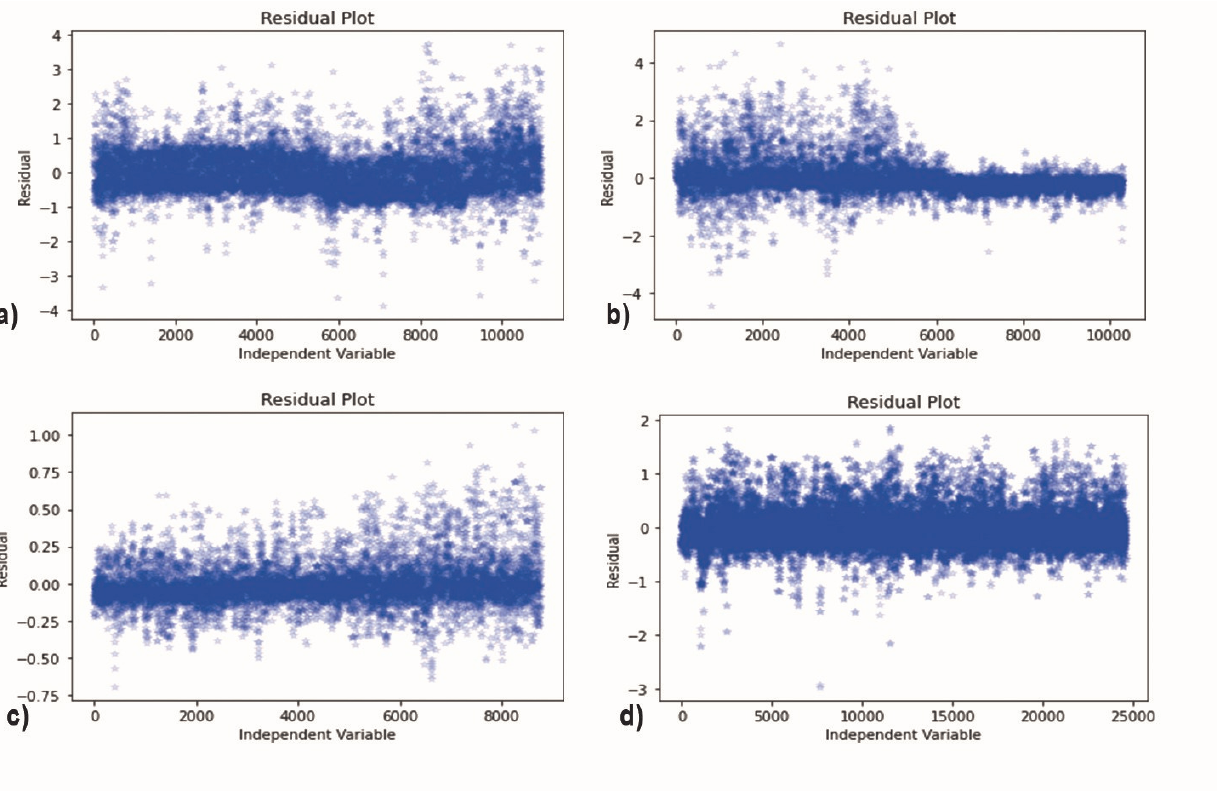
Figure 3. ( a ) Plot of the residuals resulting from the multivariate linear regression for subject F0110. ( b ) Plot of the residuals resulting from the multivariate linear regression for subject F0207.( c ) Plot of the residuals resulting from the multivariate linear regression for subject F2810. ( d ) Plot of the residuals resulting from the multivariate linear regression for subject